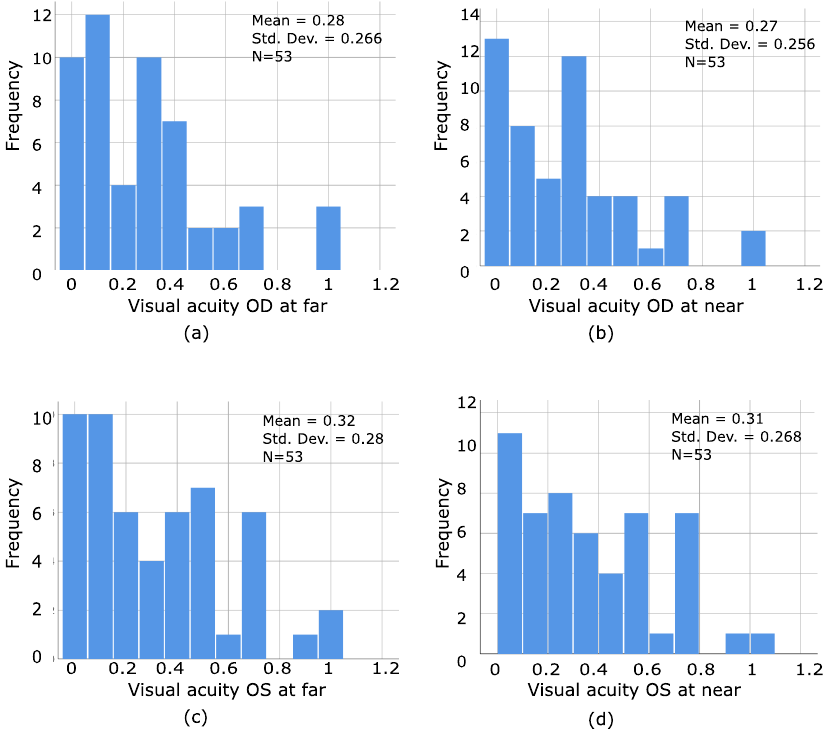
Figure 8. ( a – d ) Presents the distribution of frequencies of the amount of visual acuity of the right and left eye at far and near in stereoblind PS. As can be seen, even strabismic patients without amblyopia can be stereoblind, which reaffirms that the amount of visual acuity does not predict the presence or absence of stereopsis.